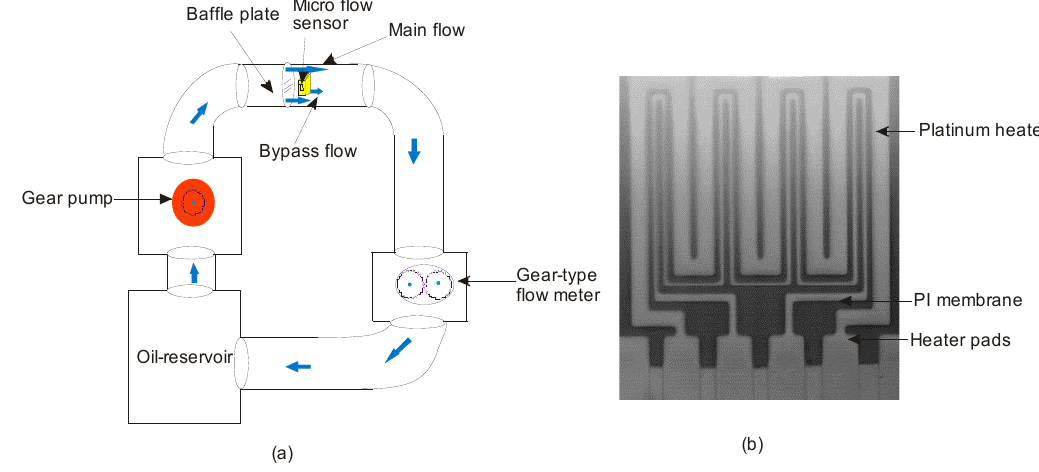
Figure 7. ( a ) Polymer-based microflow sensor for hydraulic systems; ( b ) Platinum heater on a Polyimide (PI) membrane reported by Aslam et al. [82] (reprinted with the permission from Sens. Actuat. Chem. B ).